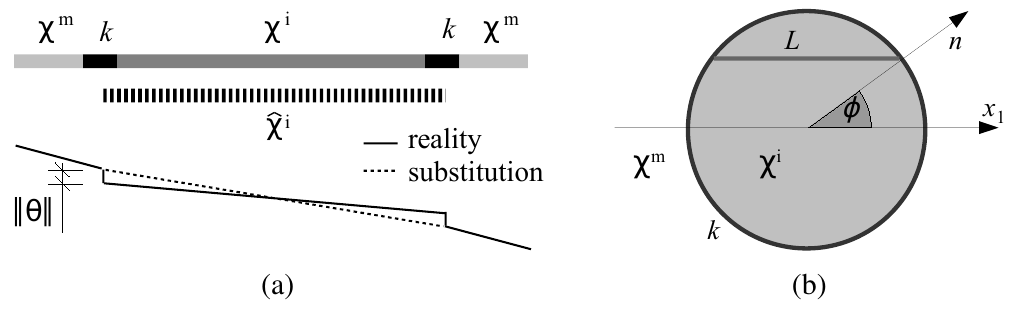
Figure 11. Imperfect interface and temperature progress for: ( a ) 1D, ( b )